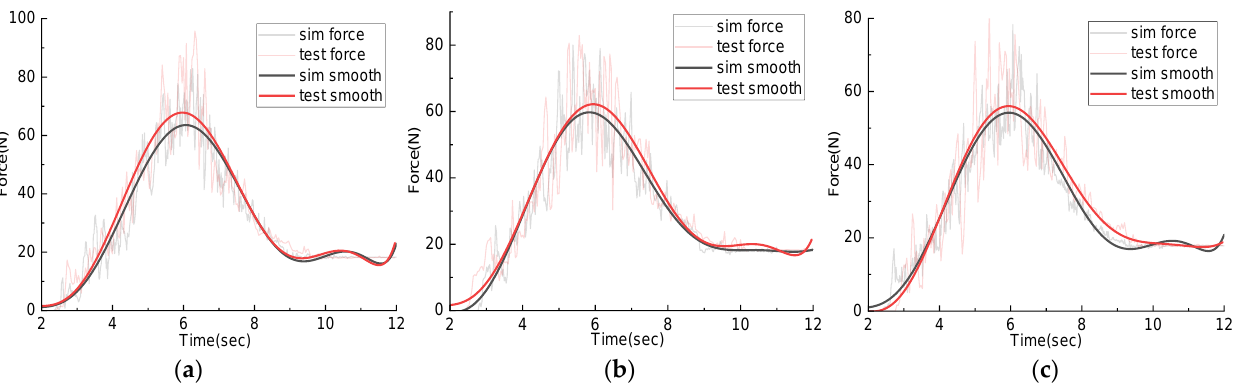
Figure 17. Comparison between simulation data and experimental data of excavation resistance under different pile angles: ( a ) 45° material surface excavation; ( b ) 40° material surface excavation; ( c ) 35° material surface excavation. Table 7. Comparison between simulation and experimental data under different working condi- tions.